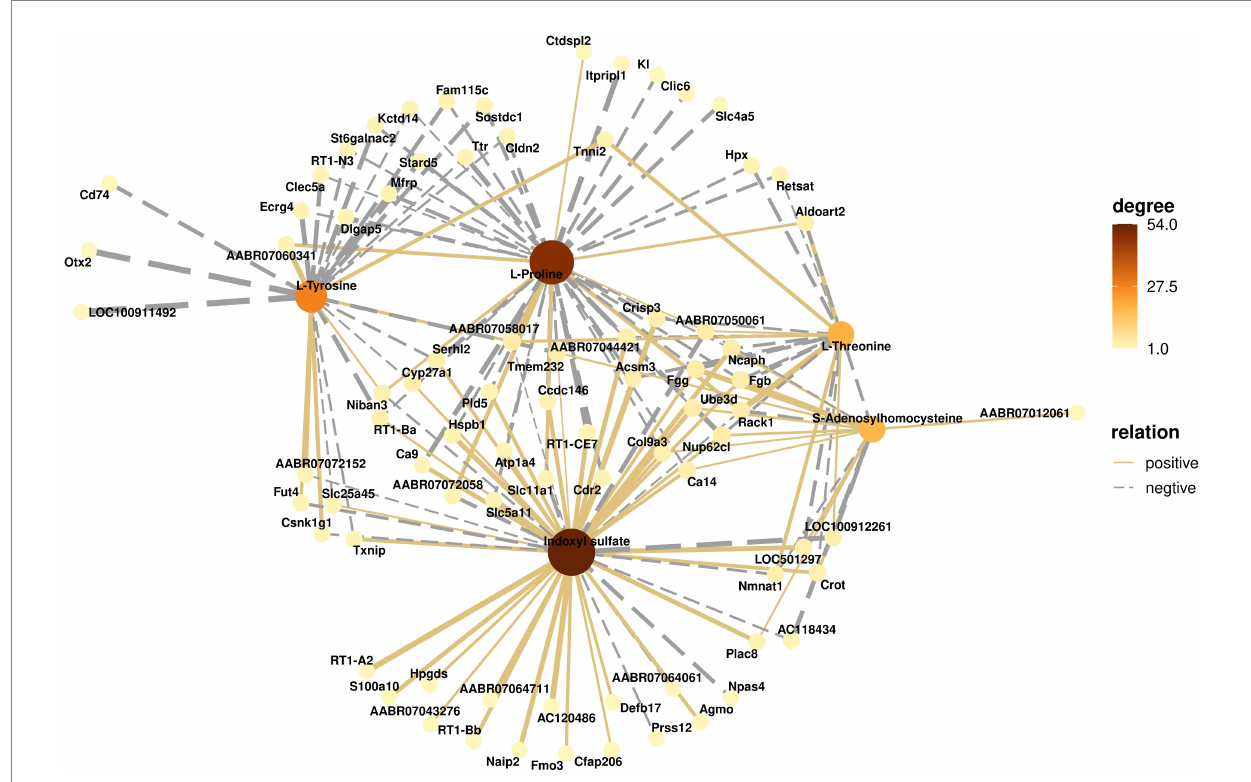
FIGURE 8 Correlation network analysis of metabolites and genes. The solid line connecting metabolites and genes represents a positive correlation, and the dashed line represents a negative correlation. The darker the color of the metabolite, the greater the number of related